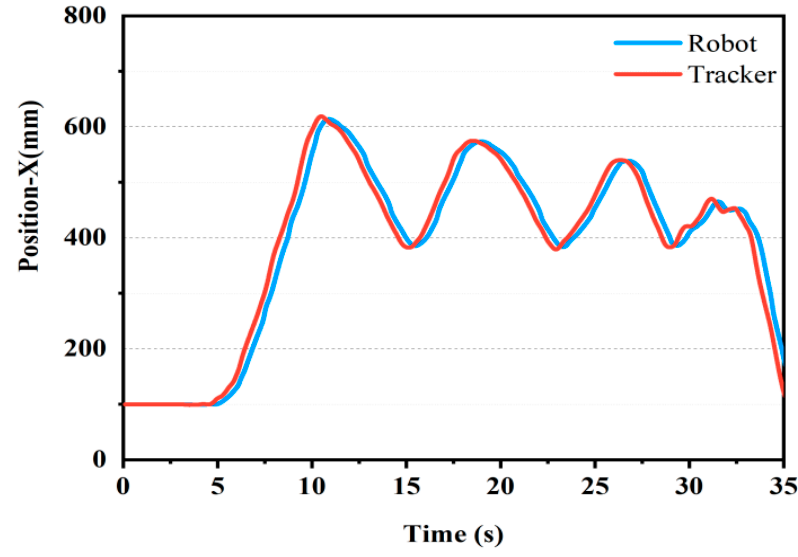
Figure 7. Position tracking accuracy in the X direction.